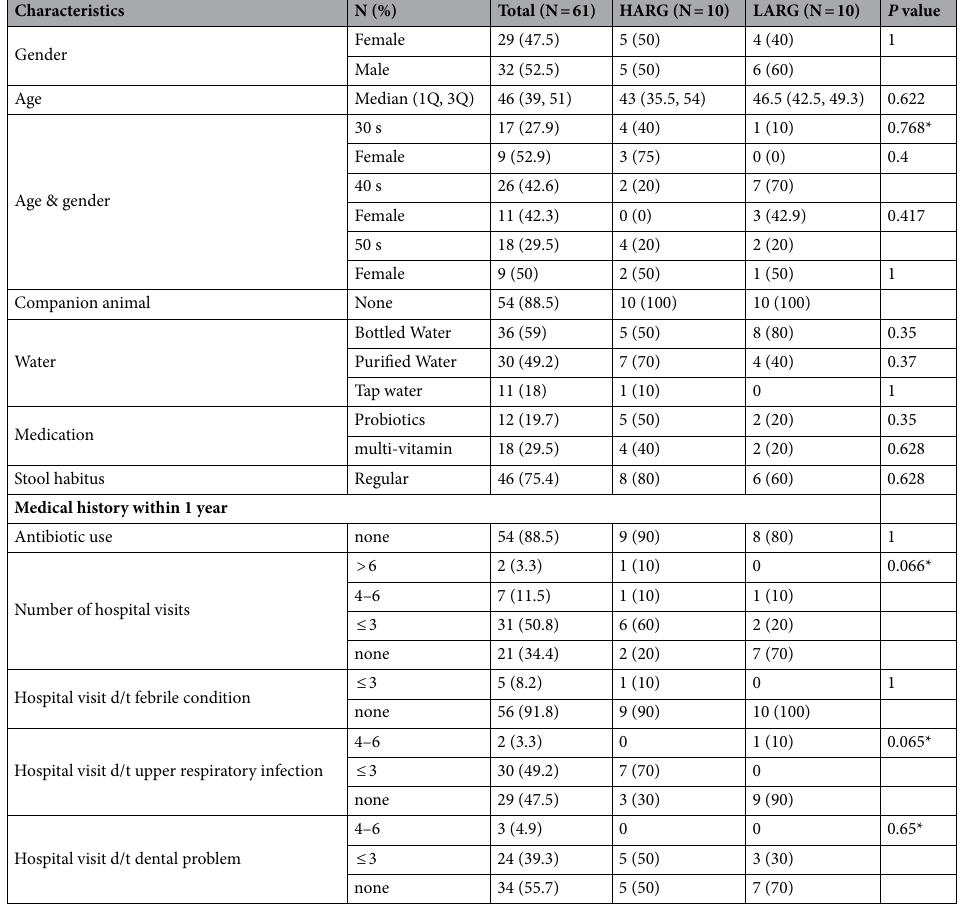
Table 1. Comparison of demographic data and personal or medical history between people with HARG and LARG in the gut. * p for trend. HARG high antibiotic resistance gene, LARG low antibiotic resistance gene, d/t due to, Q